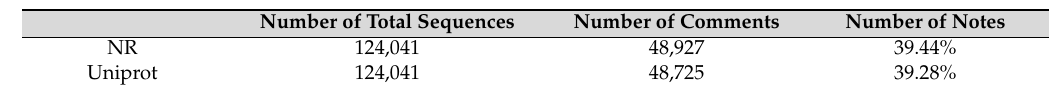
Table 3. Annotation